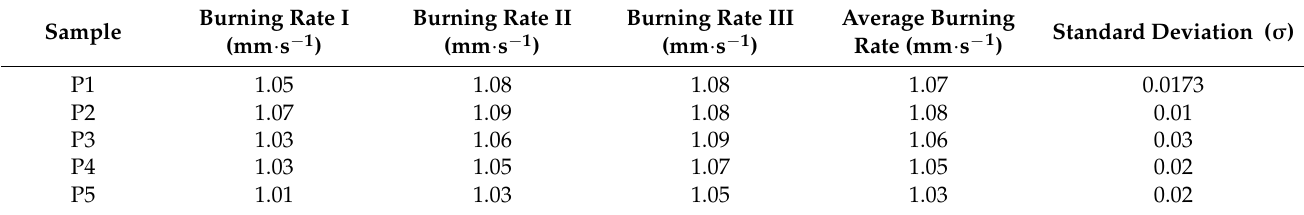
Table 3. Test results of the burning rate of samples.